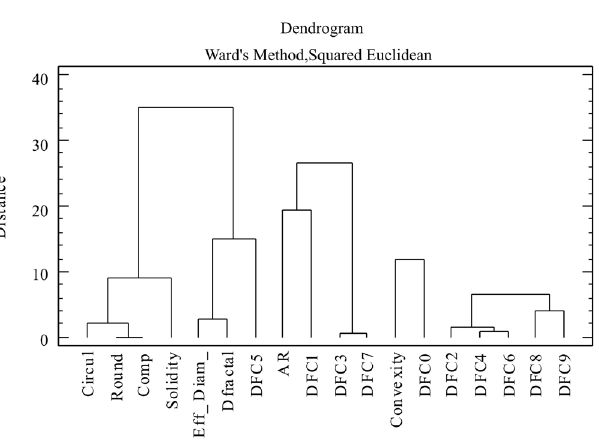
FIGURE 4 - Dendrogram showing groupings of the variables on the conglomerate analysis by the Ward Method, using squared Euclidean as metric